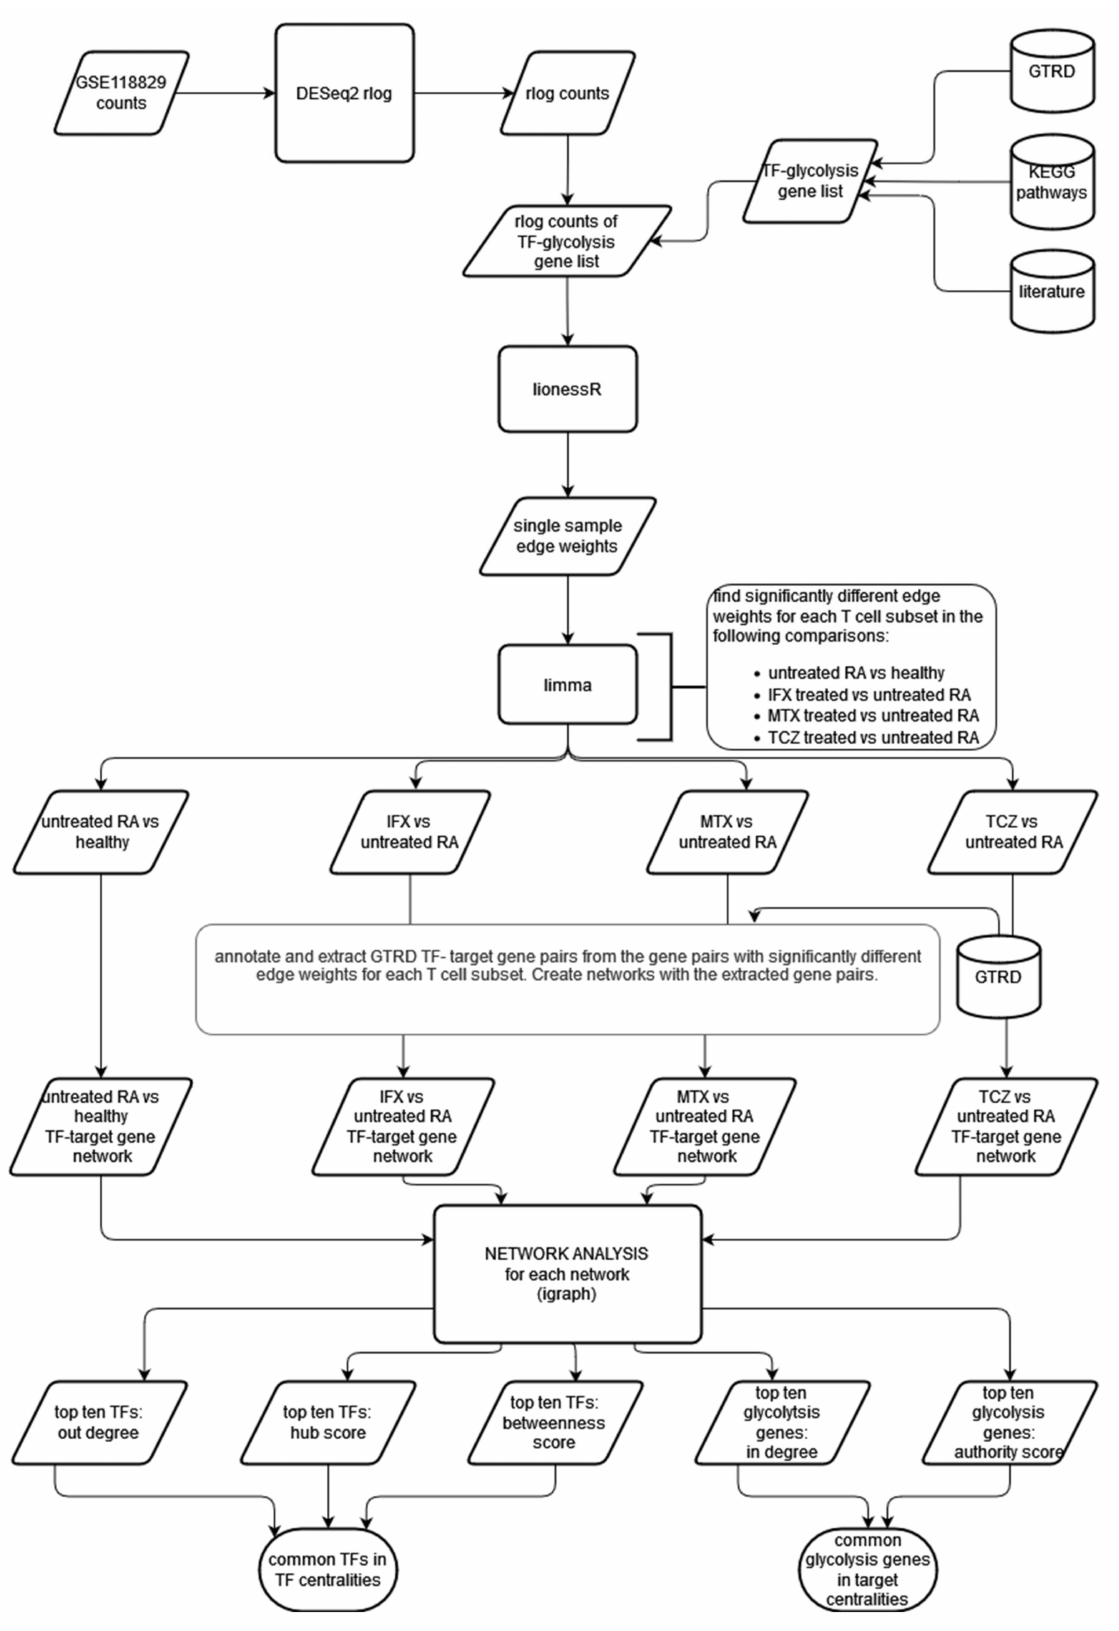
Figure 1. Overview of the workflow. TF—transcription factor; IFX—infliximab–methotrexate combi- nation therapy; MTX—methotrexate monotherapy; TCZ—tocilizumab